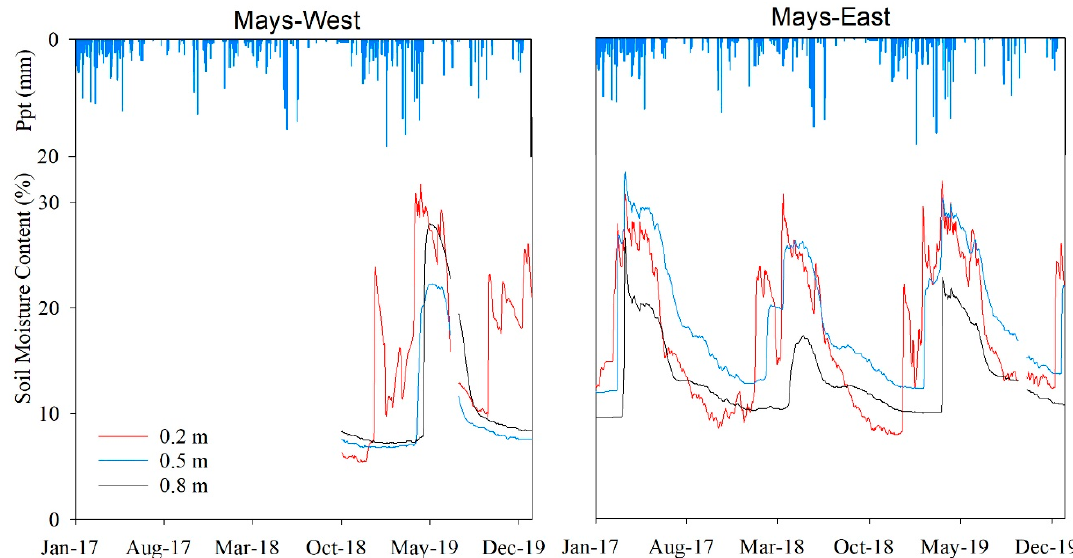
Figure 4. Daily averaged precipitation (Ppt) and soil moisture content ( θ ) at different soil depths (0.2, 0.5, and 0.8 m) in inter-canopy zones for the Mays-East and Mays-West monitoring locations in Mays WS.